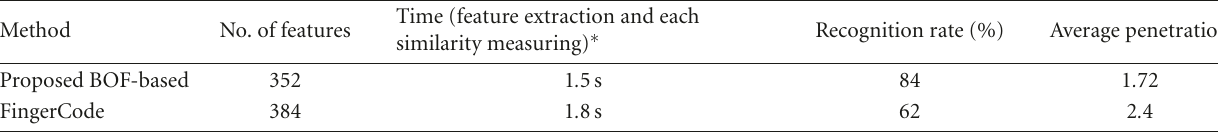
Table 1: Specifications of proposed BOF-based similarity measure and FingerCode.